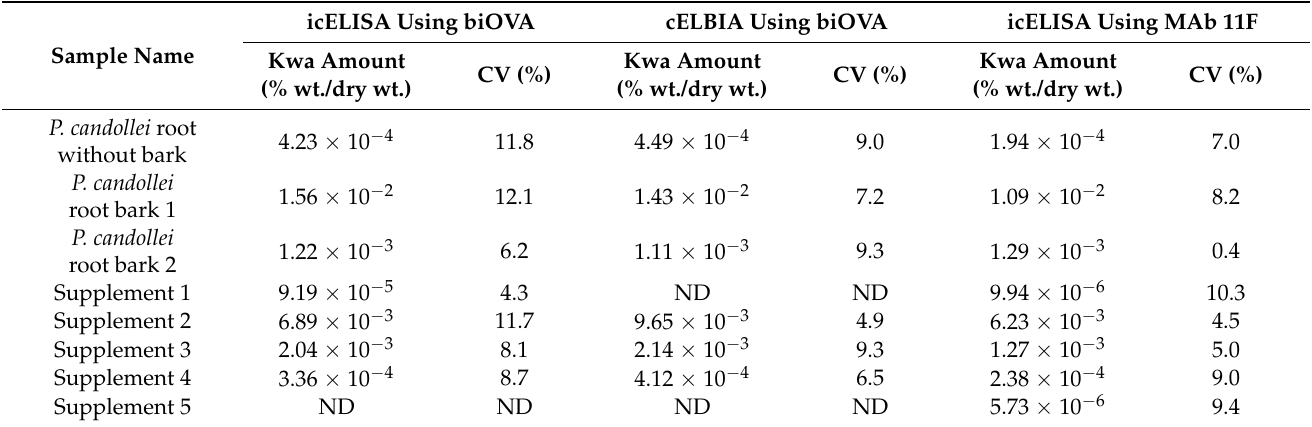
Table 2. The determination of Kwa by the icELISA and cELBIA using biOVA in P. Candollei -derived samples and